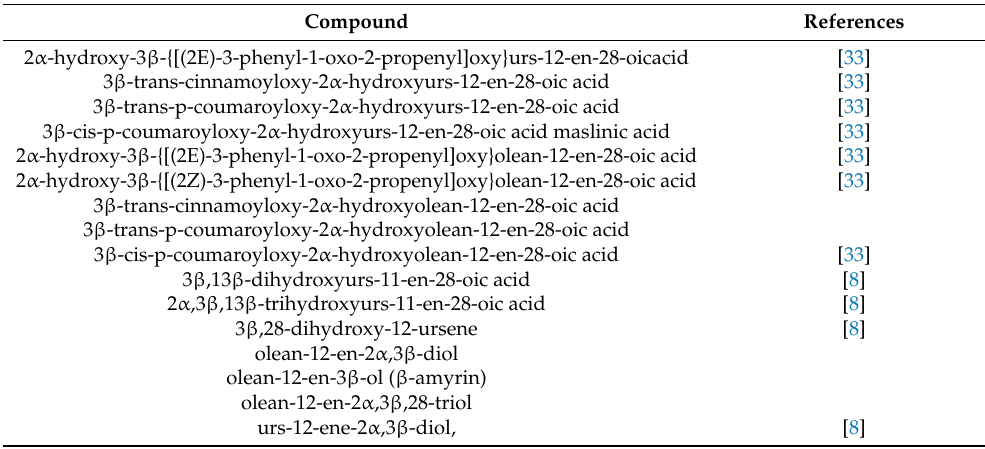
Table 5. The triterpenes isolated from the apple